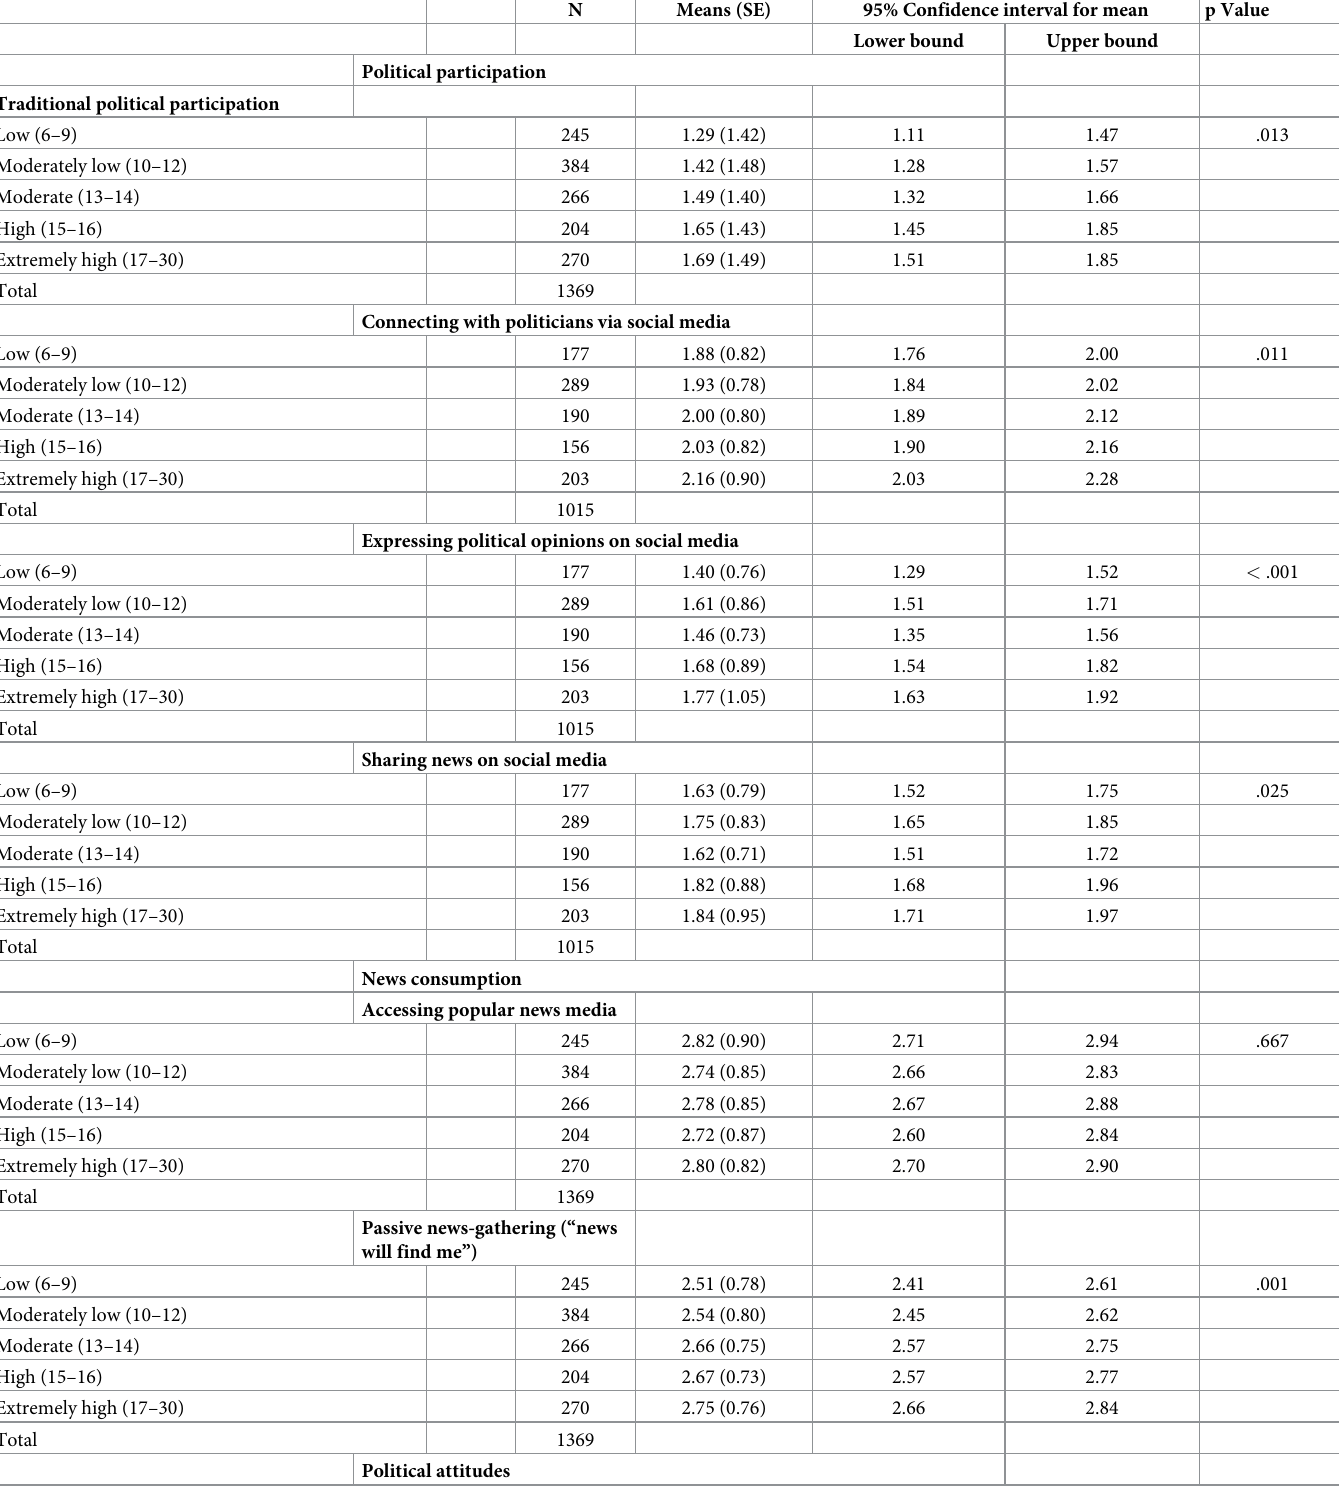
Table 3. Political attitudes and participation patterns of the study population—continuous analysis (ANOVA). N Means (SE) 95% Confidence interval for mean p Value Lower